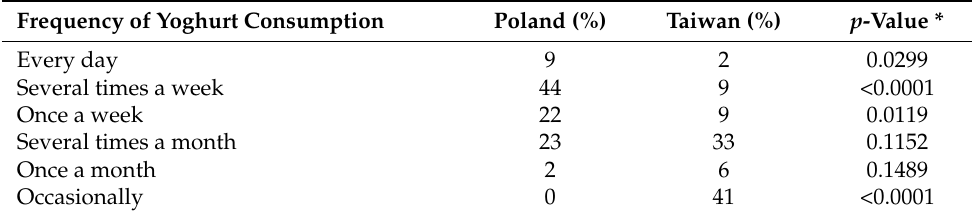
Table 3. Yoghurt consumption frequency.